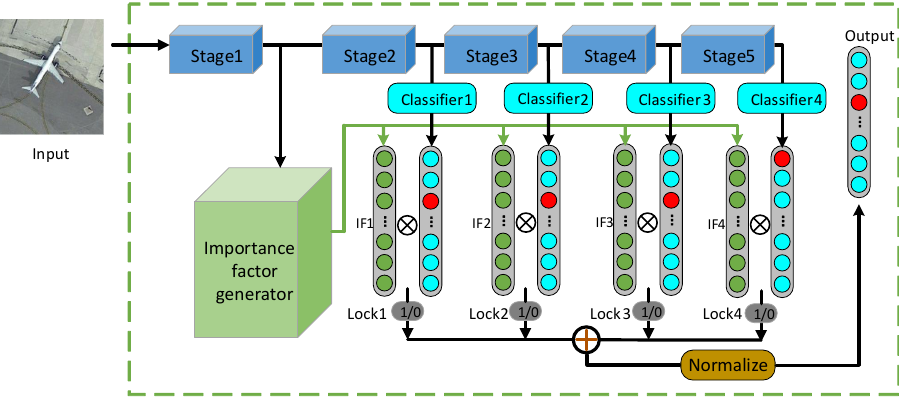
Figure 3. The framework of the proposed adaptive decision-level fusion method. From top to bottom, the blue blocks represent different stages of a deep CNN backbone; the light blue rectangles with round corners are the classifiers based on the features of different stages; the green block is the importance factor generator, which is used to generate the importance factor matrix composed from “ IF 1” to “ IF 4”; the grey blocks named as “Lock 1” to “Lock 4” represent the stochastic decision-level fusion process.